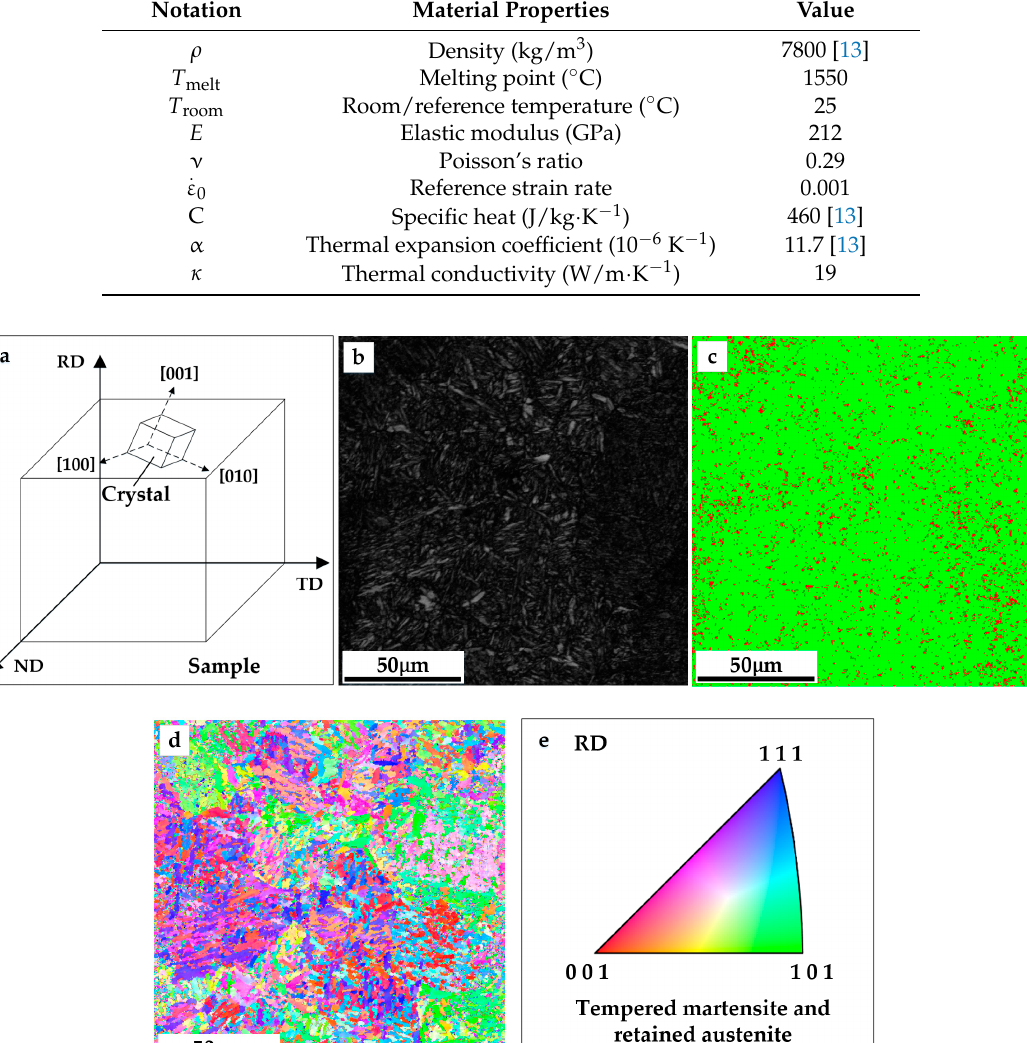
Table 2. Physical and mechanical properties of 45CrNiMoVA used for simulation. Notation